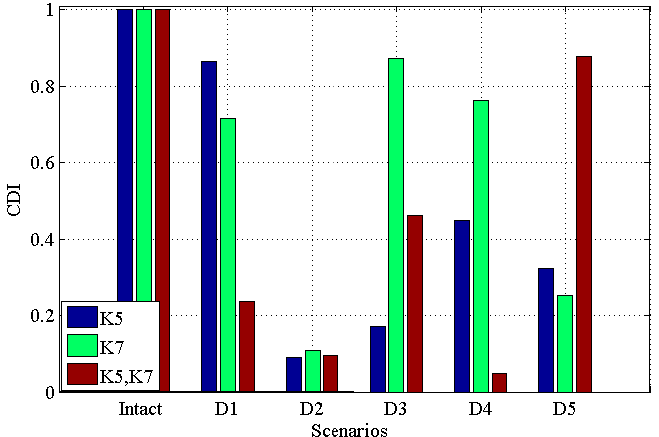
Figure 3. Correlation-based damage indicator ( CDI ) for five damaged scenarios with intact scenario for single damage in K5, single damage in K7, multiple damages in K5 and K7 respectively.